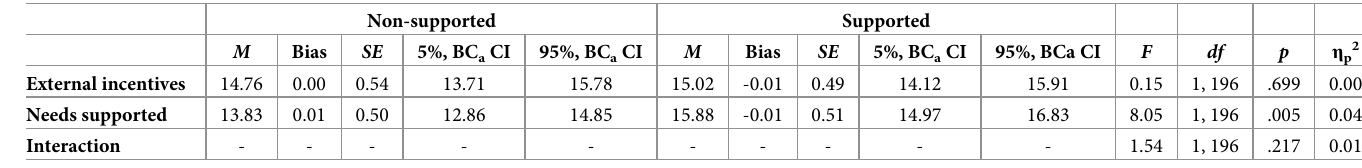
Table 2. Two-way between-subjects bootstrapped ANOVA for task performance level in Study